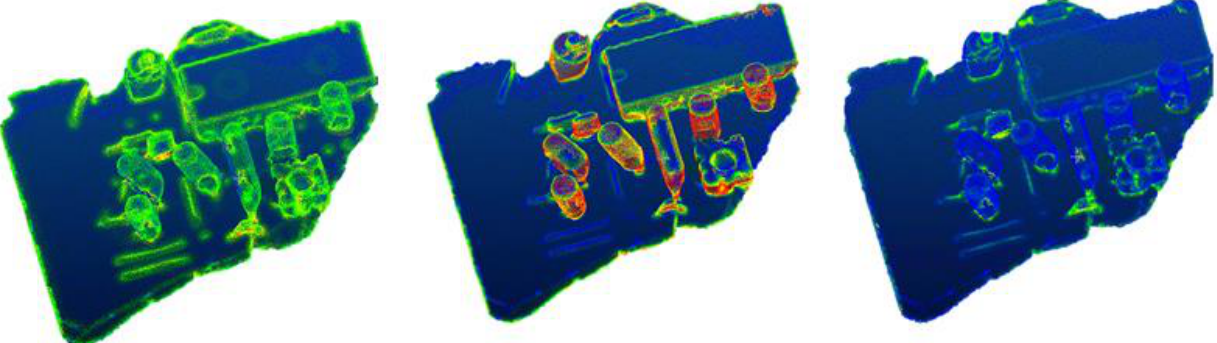
Figure 7. Visualization of 3D features. Omnivariance ( left ), Verticality ( middle ) and Normal Change Rate ( right ).